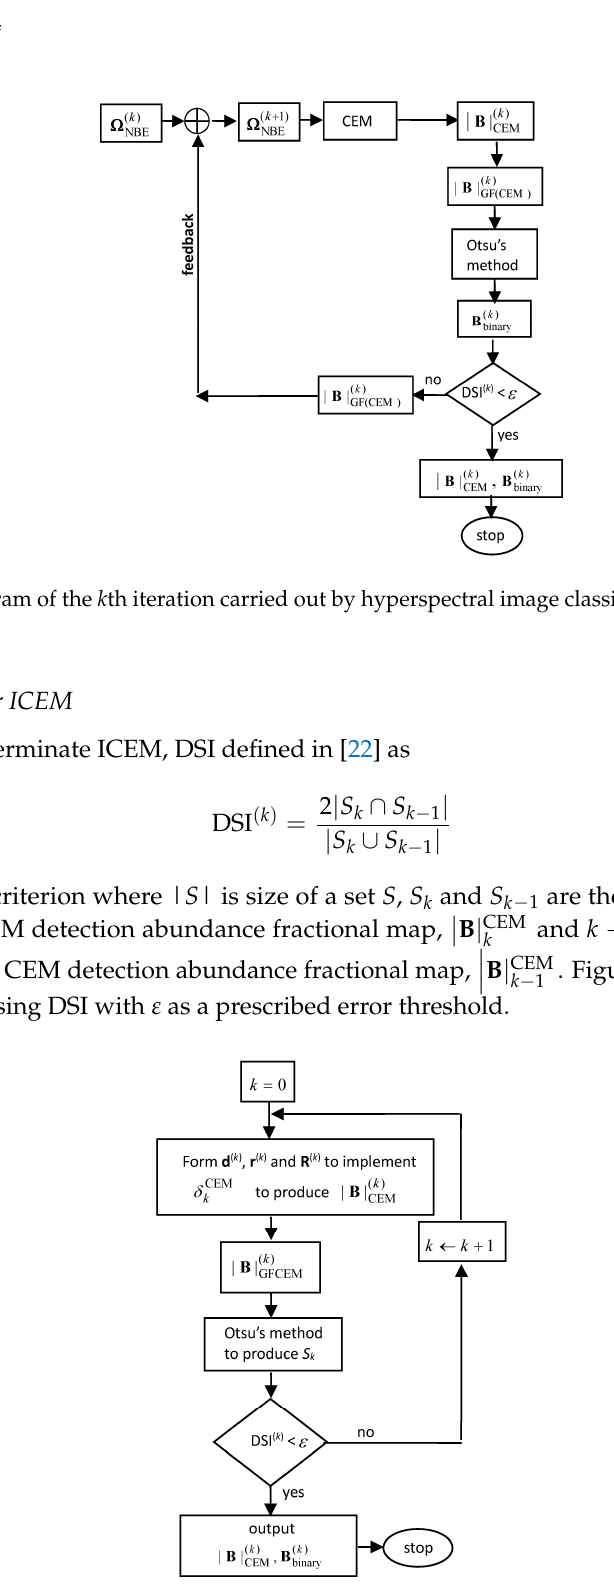
Figure 2. A flow chart of the stopping rule used for NBE-ICEM.